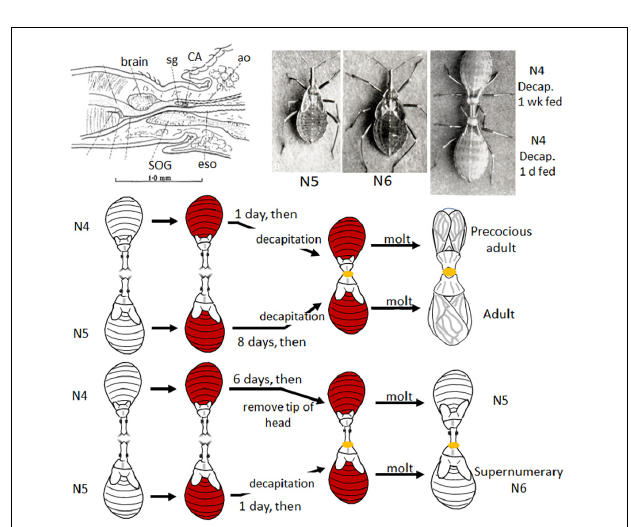
FIGURE 2 | Top : Diagram of brain and corpus allatum (CA) of Rhodnius (modified from Figure 2 in Wigglesworth, 1934); Rhodnius 5th instar (N5), supernumerary 6th instar (N6), and parabiosed, fed and decapitated (decap) 4th instar (N4) (top one decapitated one week after feeding, the bottom 1 day after feeding) nymphs [photos from Plates I and II in Wigglesworth (1954), reproduced with permission]. Bottom : Cartoon of two parabiosis experiments: (1) (top) a 4th instar nymph decapitated 1 day after feeding and parabiosed to a 5th instar nymph decapitated 8 days after feeding (thus ready to molt) molted to a precocious adult; (2) a parabiosed 4th instar nymph with only the tip of the head removed (leaving the CA intact) 6 days after feeding parabiosed to a 5th instar nymph decapitated only 1 day after feeding caused the latter to molt to a supernumerary 6th instar nymph (Wigglesworth, 1934). See text for details. ao, aorta; eso, esophagus; sg, sympathetic ganglion; SOG, subesophageal